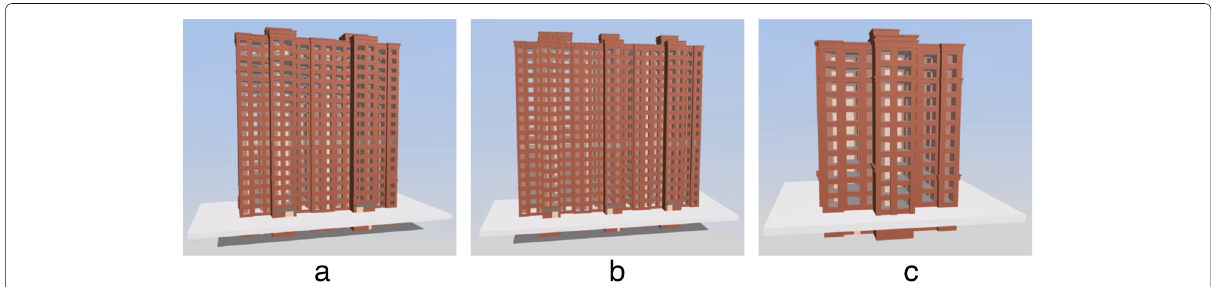
Fig. 7 Three test models for loading and displaying. a M1 b M2 c M3